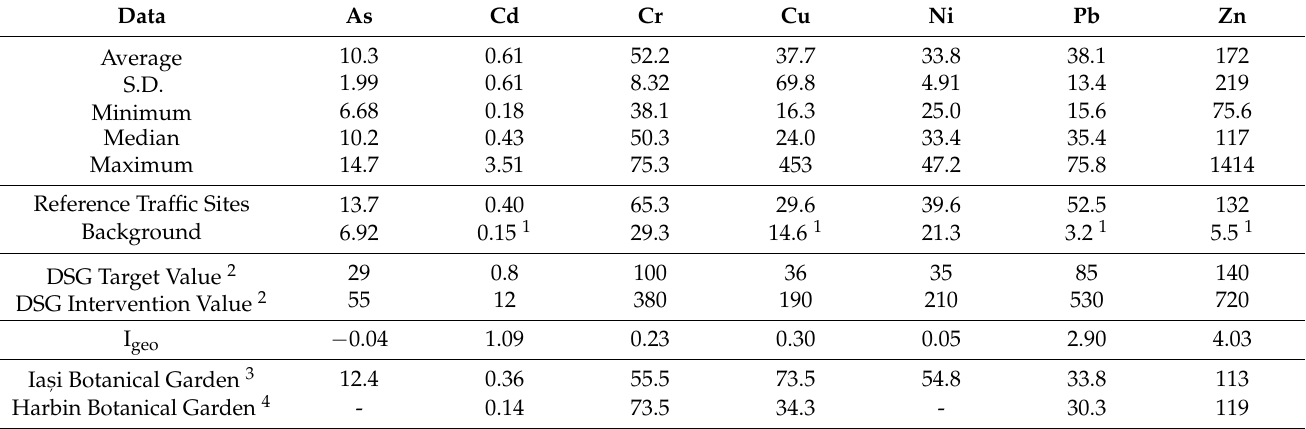
Table 1. PTE contents (mg/kg) in botanical garden soils, garden surroundings, standards (DSG = Dutch Soil Guidelines), contamination assessment (I geo ) and PTE contents in other gardens (mean values in